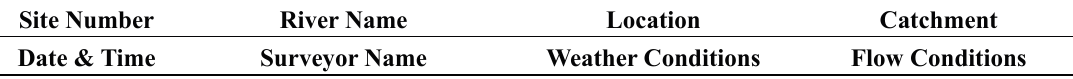
Table A1. Scoring system for assessment of river habitat in the Hai River